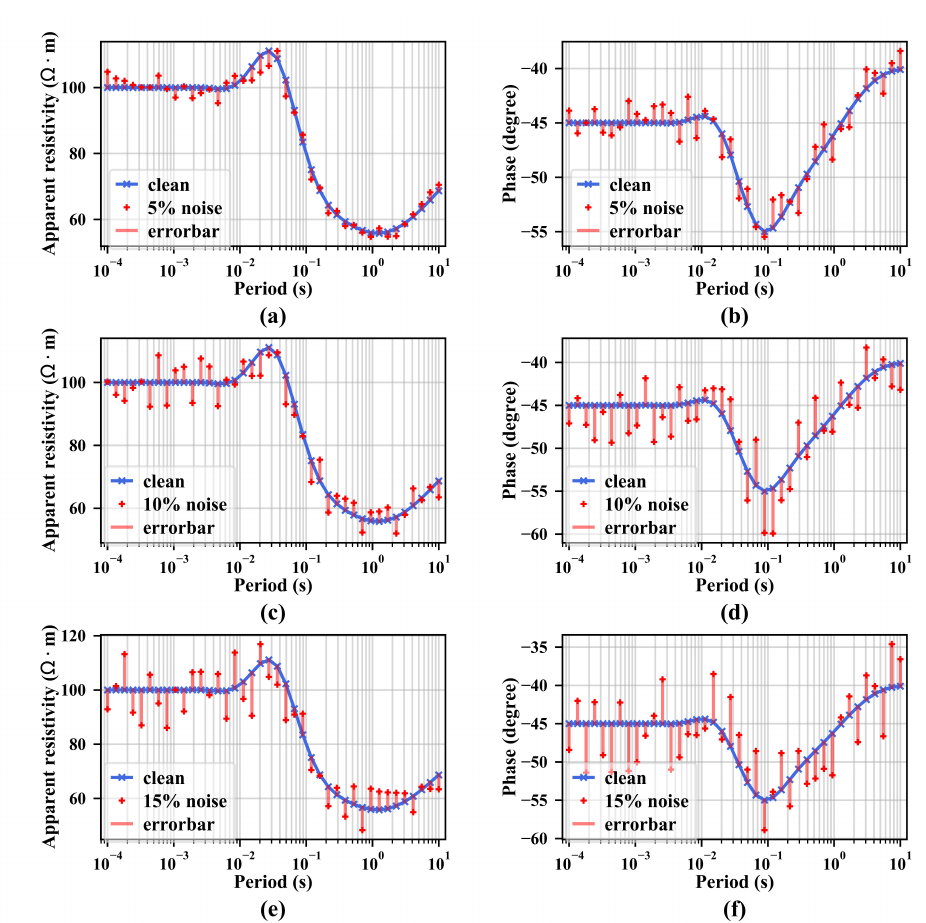
Figure 11. Supposed MT responses of a five-layer geoelectric model with different levels of noise. ( a , b ) represent the MT responses when the noise level is 5%. ( c , d ) represent the MT responses when the noise level is 10%. ( e , f ) represent the MT responses when the noise level is 15%. ( a , c , e ) represent the apparent resistivity responses. ( b , d , f ) represent the apparent resistivity responses. The blue lines represent the clean supposed responses. The red dots indicate the noisy responses. The red lines are the error bars between the noisy data and clean